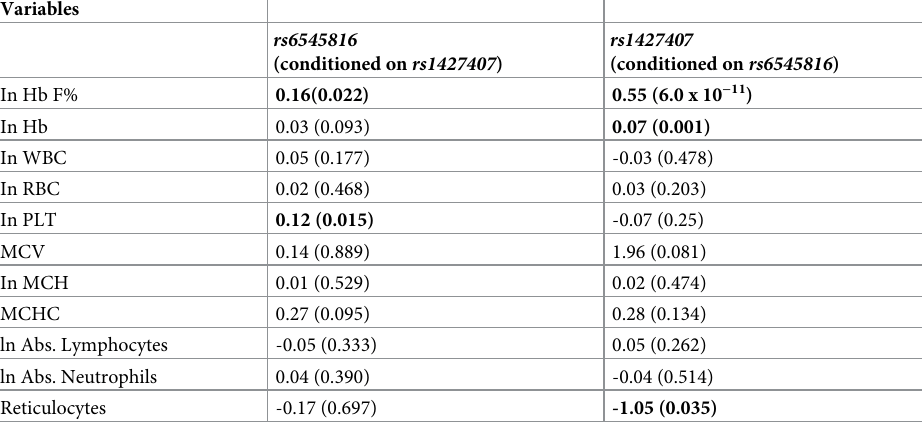
Table 3. Joint analysis of the BCL11A variants rs6545816 and rs1427407